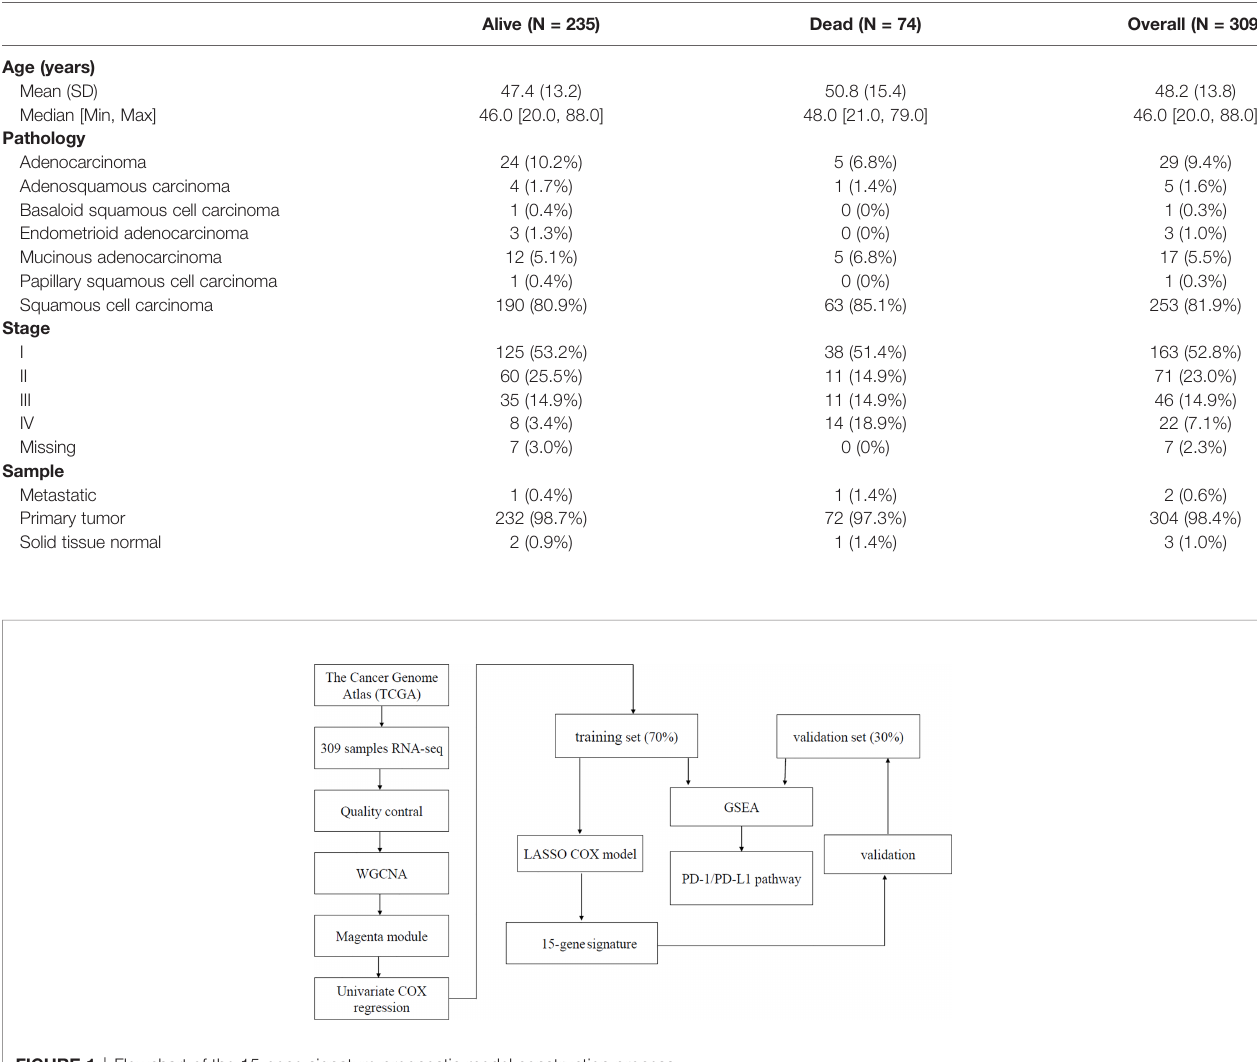
TABLE 1 | Clinical characteristics of 309 samples from